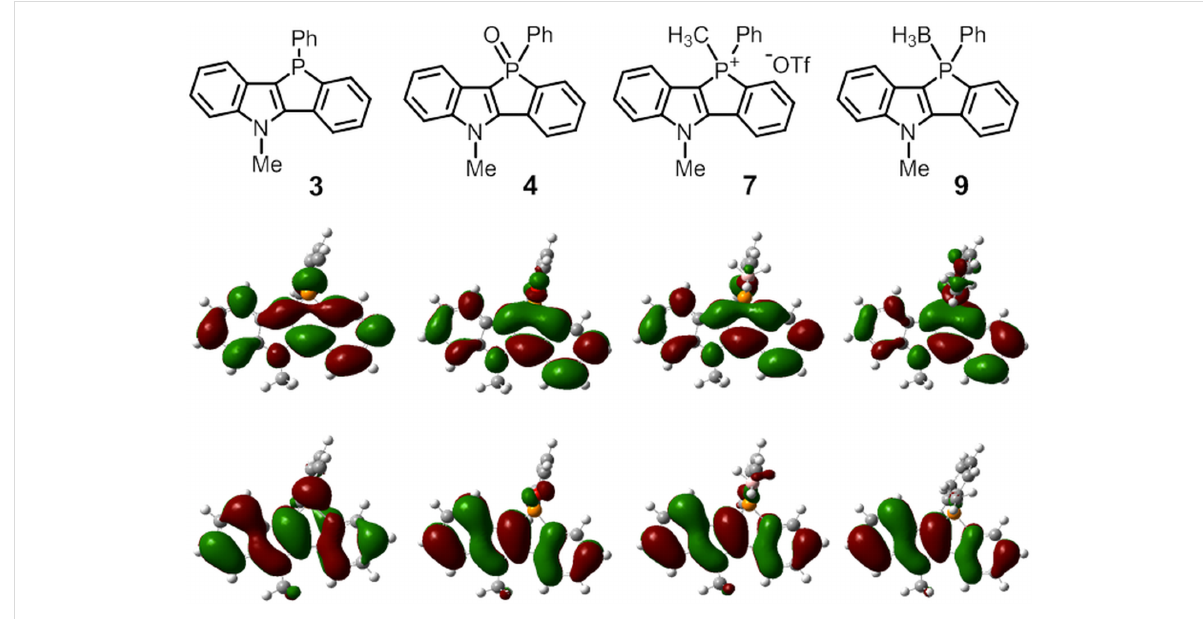
Figure 4: The spatial plots of the HOMO and LUMO of compounds 3 , 4 , 7 and 9 . The calculations were performed at the level of B3LYP/LanL2DZ.